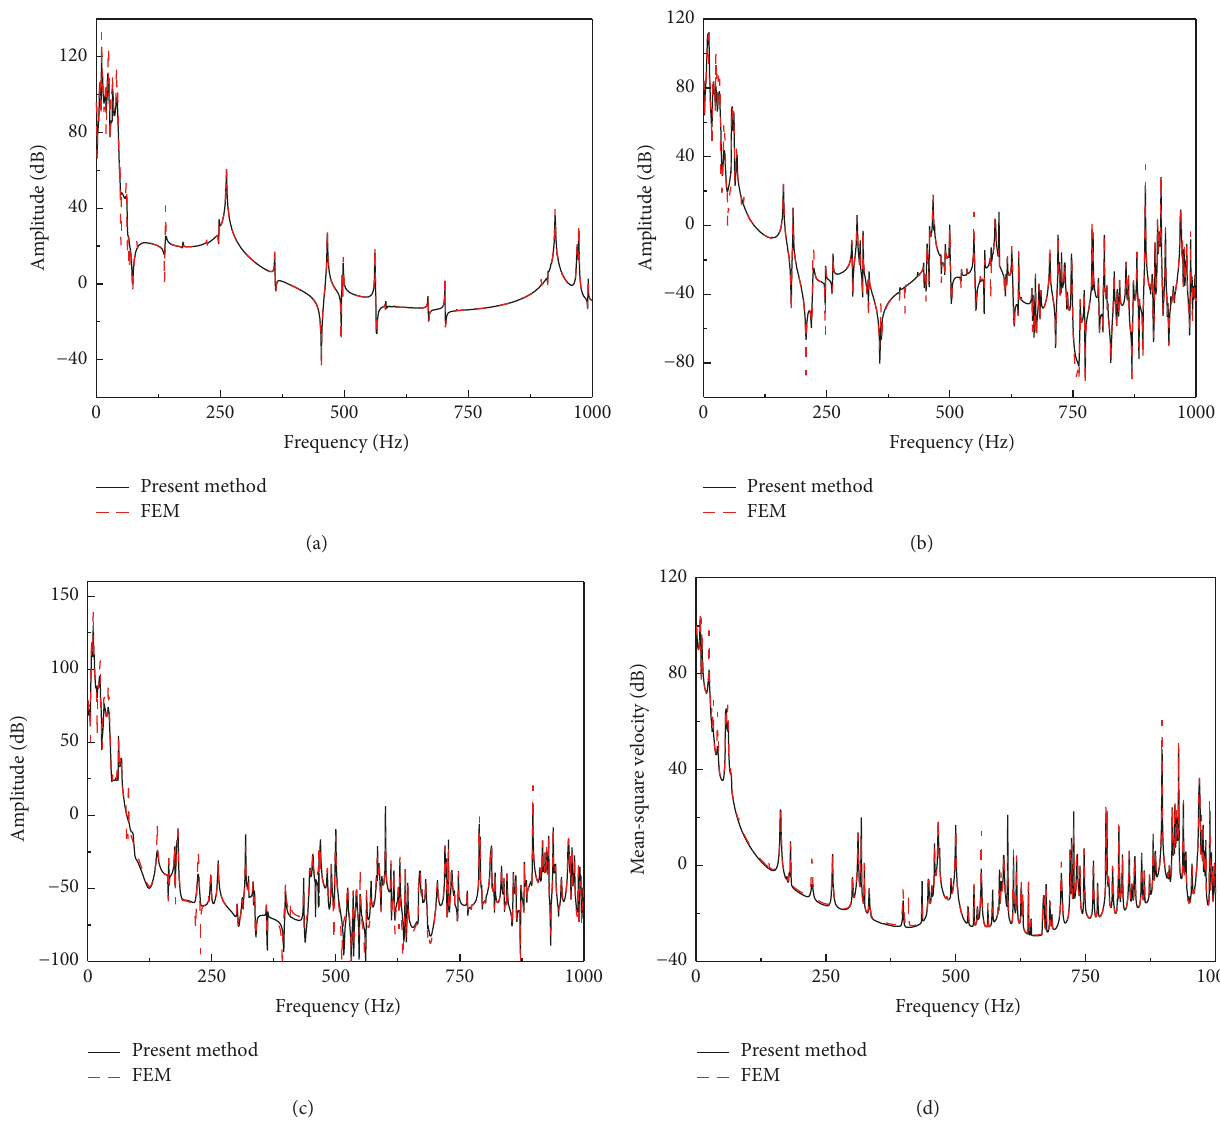
Figure 4: Comparison of the synthesized FRFs and the simulated results excited by single-sourced single-direction force: (a) displacement of the lower isolator in 𝑧 -direction; (b) displacement of the lower isolator in 𝑥 -direction; (c) displacement of point between hull and attached pipes in 𝑧 -direction; (d) mean-square velocity of hull